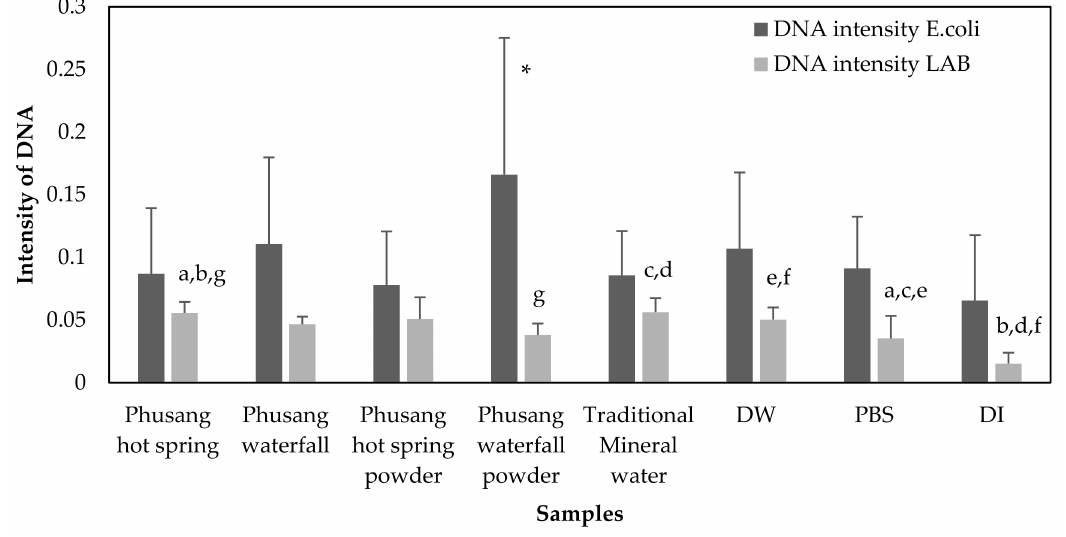
Figure 11. Differences in DNA intensity from cultured E. coli and LAB treated with different water samples. (a, b, c, d, e, f, and g = statistically significant differences, * = statistically significant differences compared with other samples).